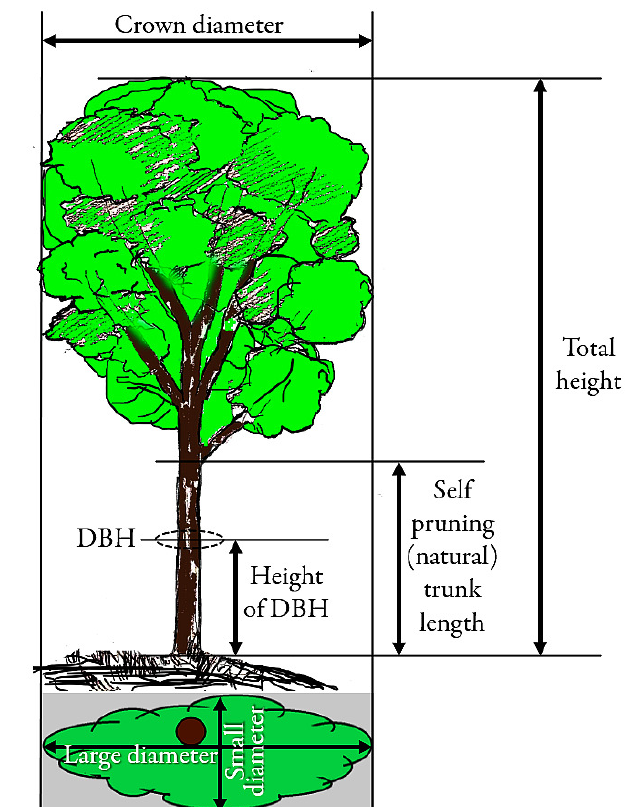
Figure 1. The main growth traits measured at the trees chosen as ‘plus’ trees. At the bottom of the figure is the projection of the crown at ground level, determined by maximum and minimum diameter